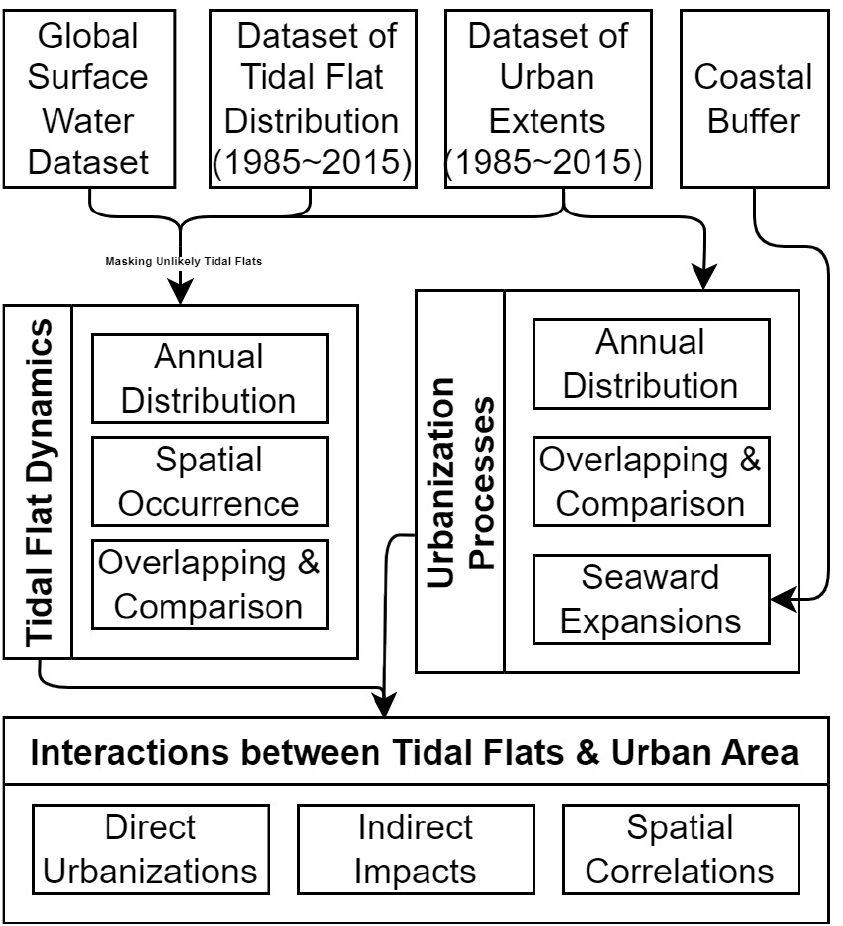
Figure 2. The overall framework for analyzing the spatiotemporal dynamics of tidal flats and urban extents, as well as the interactions between them, from 1985 to 2015.